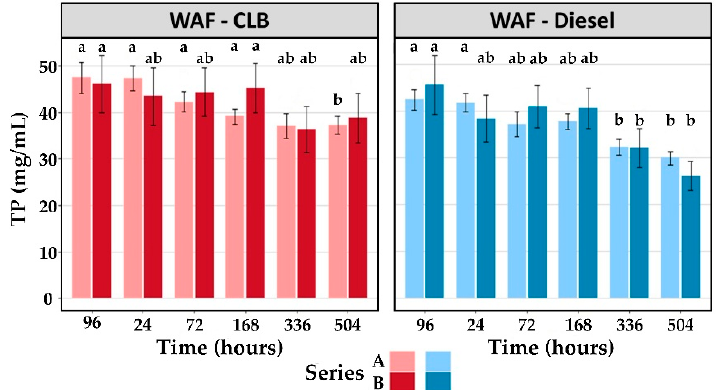
Figure 6. Total protein content (TP; mg/mL) in hemolymph, as calculated from measurements of the Brix index, of lobsters exposed to WAF-CLB and WAF-Diesel during the recovery period in series A and B. Mean ± SE; n = 3. The letter symbols indicate a significant (p < 0.05) effect between time and series.